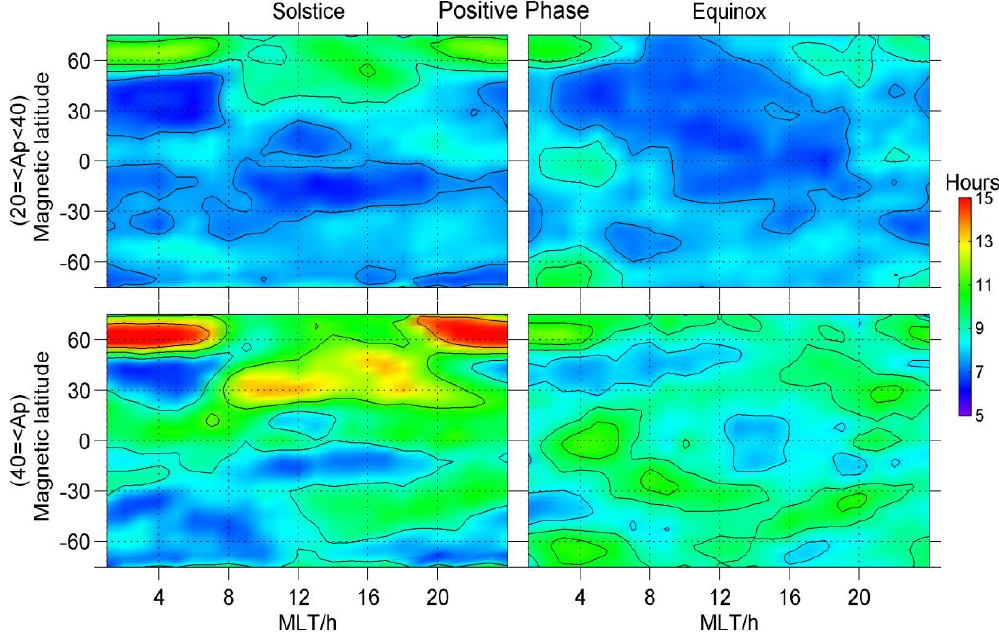
Fig. 6. Global distribution of the mean time duration related to positive ionospheric storms in the MLAT vs. MLT frame for solsticial months (left panels) and equinoctial months (right panels). The Northern Hemisphere of left panels locates in winter and the Southern Hemisphere corresponds to the summer months.